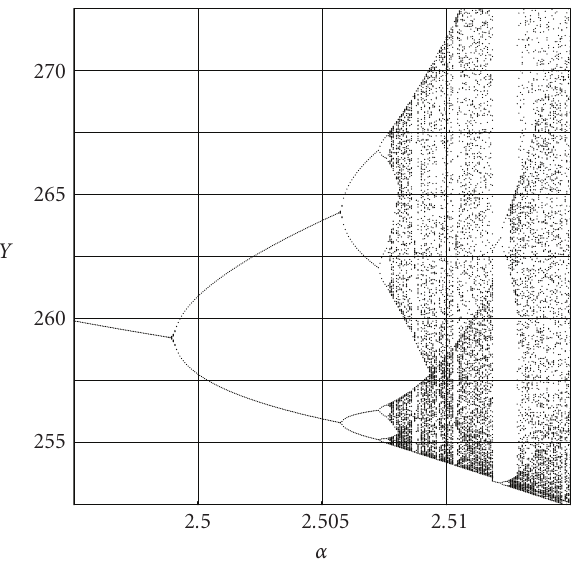
Figure 7.3. Detail of the bifurcation diagram of Y for model 2, β = 0 .